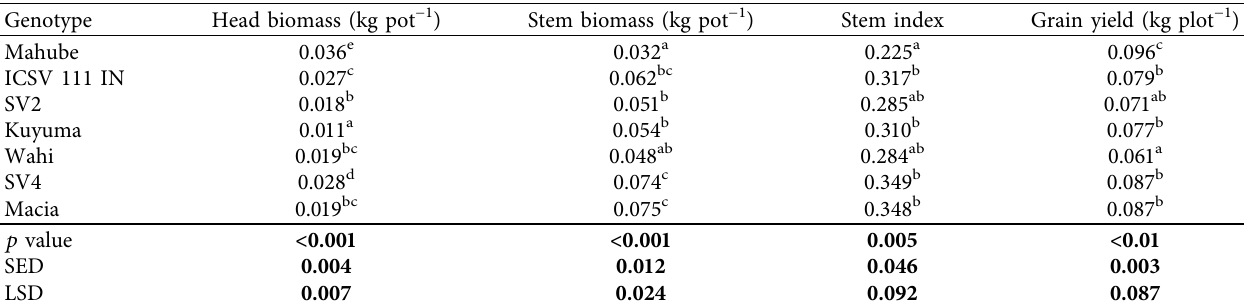
Table 9: Response of sorghum genotype on yield parameters evaluated under glasshouse conditions. Genotype